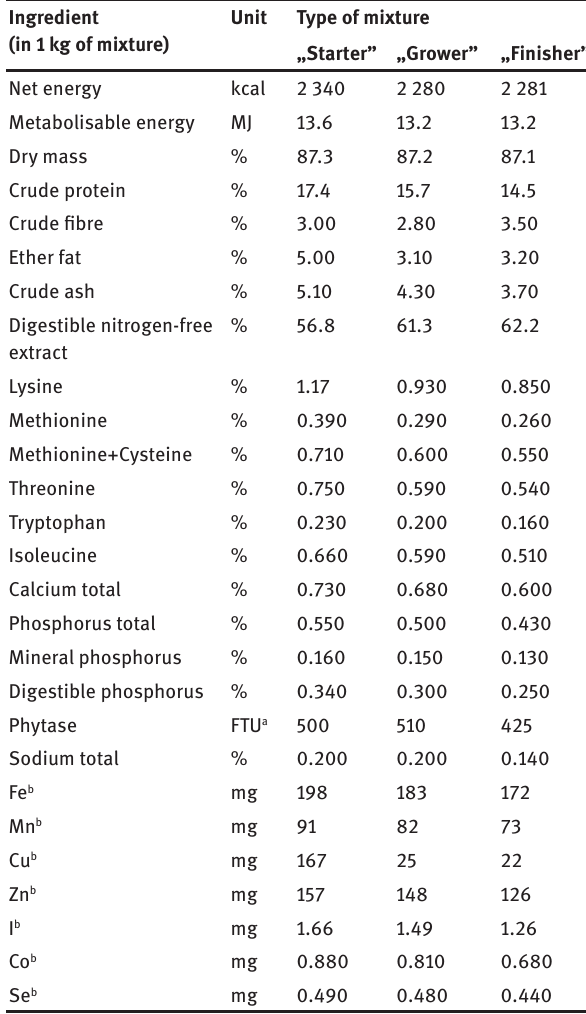
Table 1 : The composition of the standard mixture for growing pigs a . Ingredient